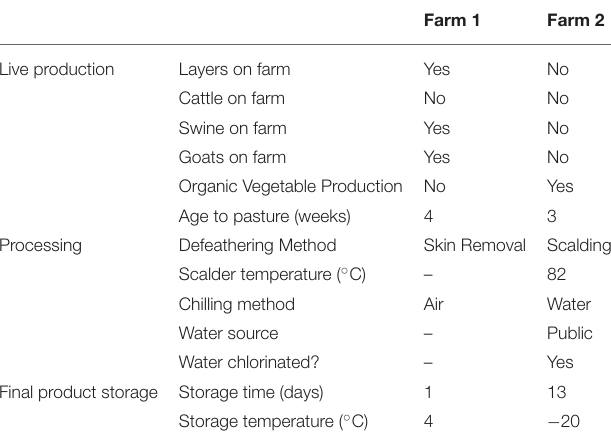
TABLE 1 | Major management differences between the two pastured broiler